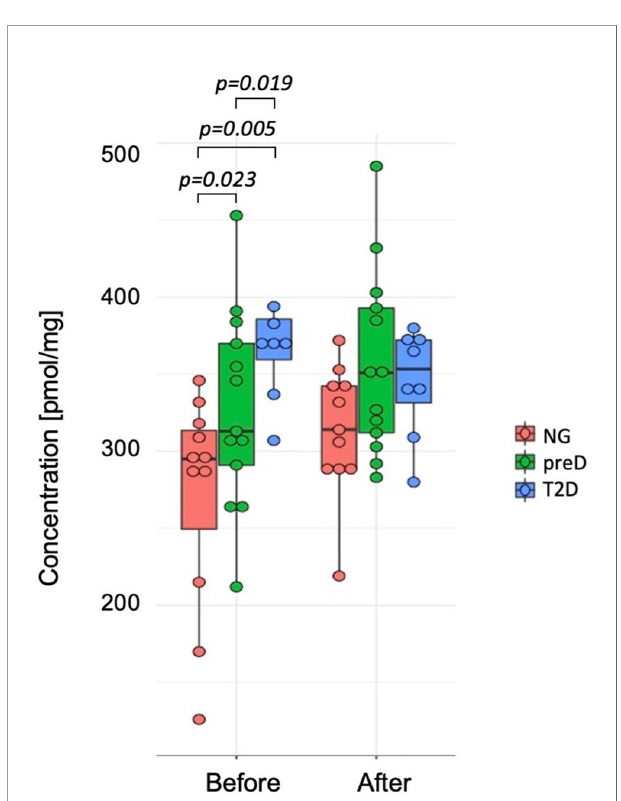
FIGURE 2 | Differences in carnosine concentrations among diagnosis groups – normoglycemia (NG), prediabetes (preD) and type 2 diabetes (T2D), before and after 3 months of exercise intervention. Mean and standard errors are